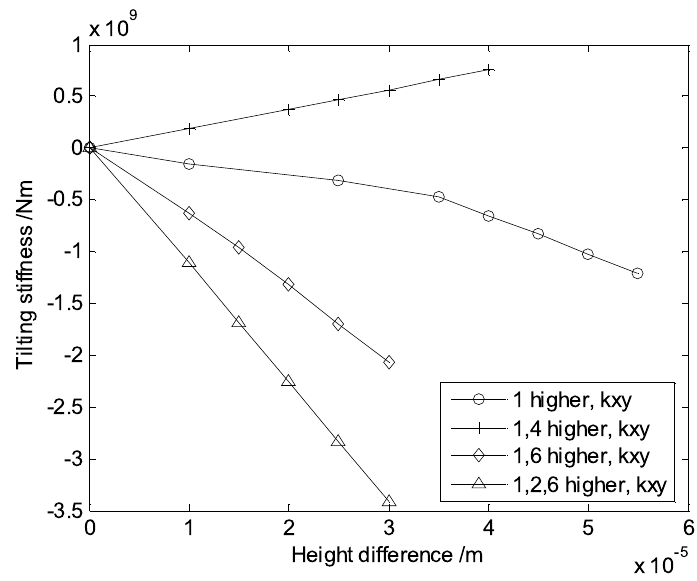
Fig. 6. Stiffness coefficient K xy versus height